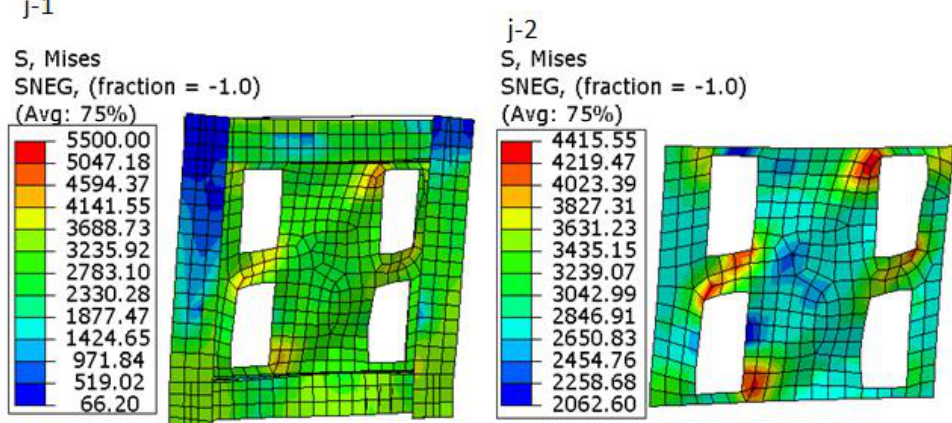
Figure 29. Von Mises stress and displacement for concrete part (k-3) stress and (k-4) displacement. Buildings 2018 , 8 , x FOR PEER REVIEW 17 of 27